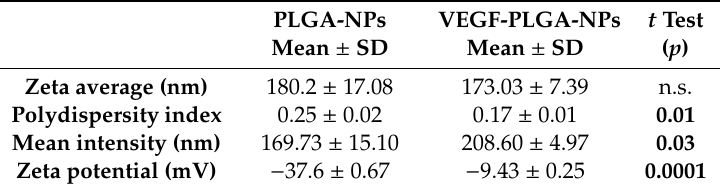
Table 1. Characterization of PLGA-NPs and VEGF-PLGA-NPs to the DLS. Data are expressed as mean ± SD of three measurements.